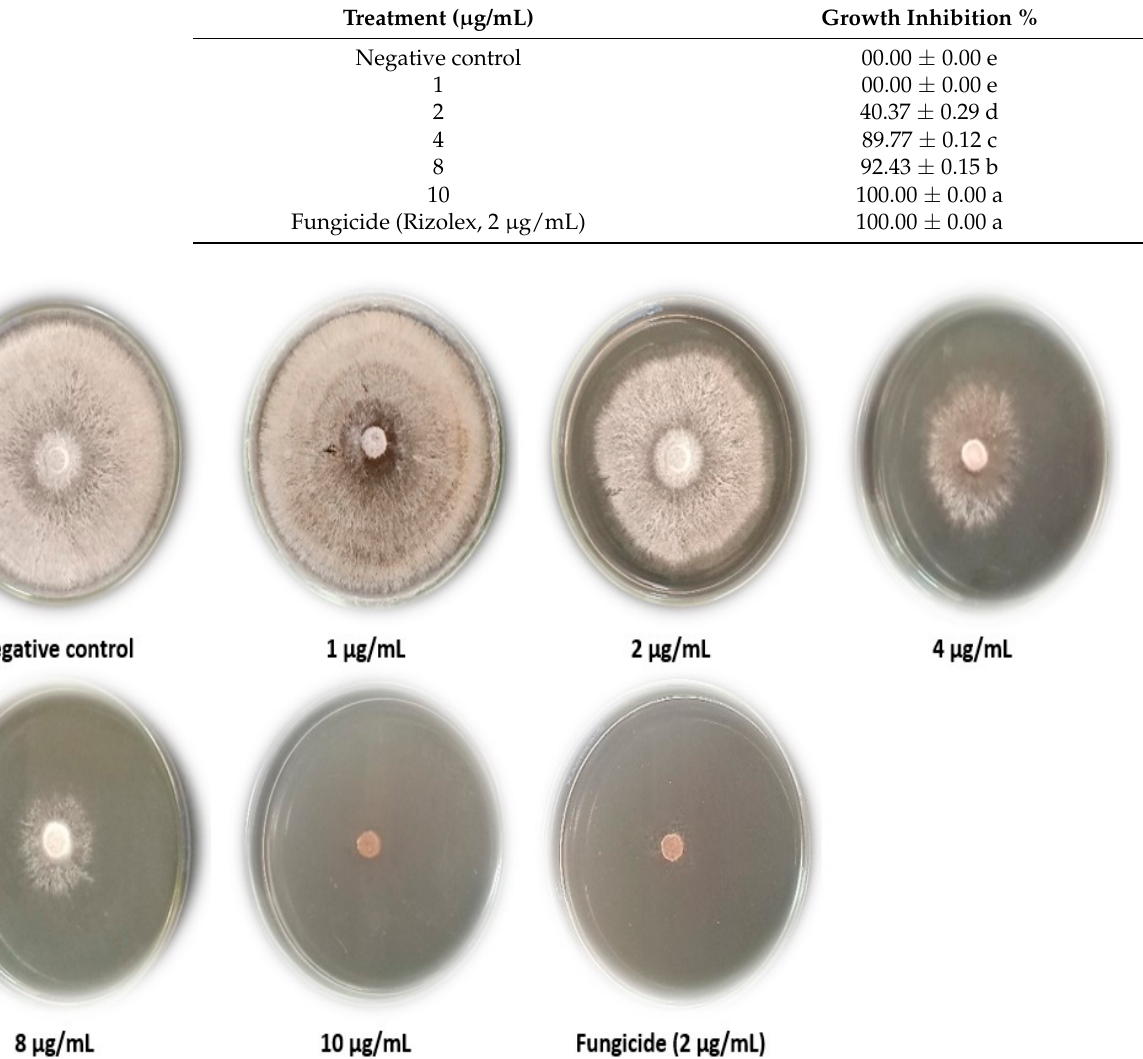
Table 2. In vitro growth inhibition (%) of R. solani in response to Chorisia speciosa extract. The different letters mean the data values were significantly different at p ≤ 0.05.